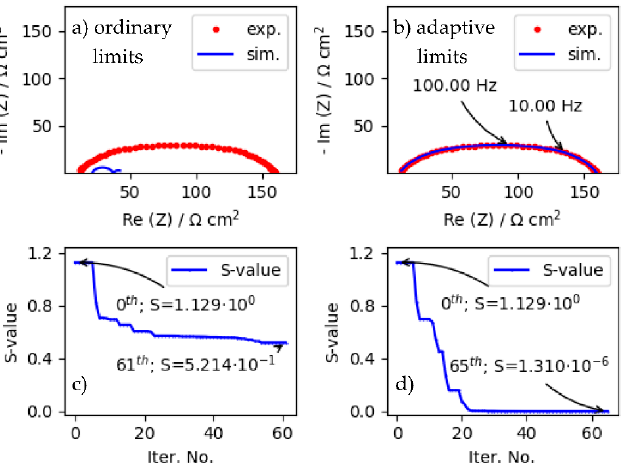
Figure 3. The impedance spectra of the ZARC data (subplots a , b ) and the corresponding S -value data (subplots c , d ). EEC R(QR)(QR)(QR) (Figure 1) was used in the fitting